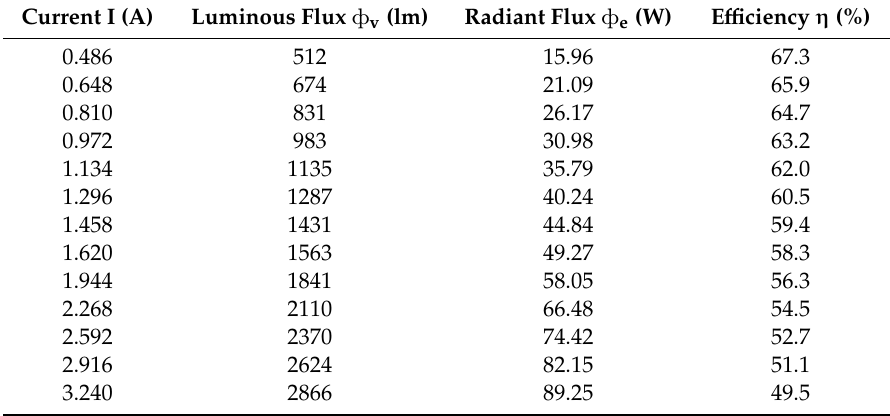
Table 1. Luminous flux, radiant flux, and efficiency of the high-power LED used as a function of the current.